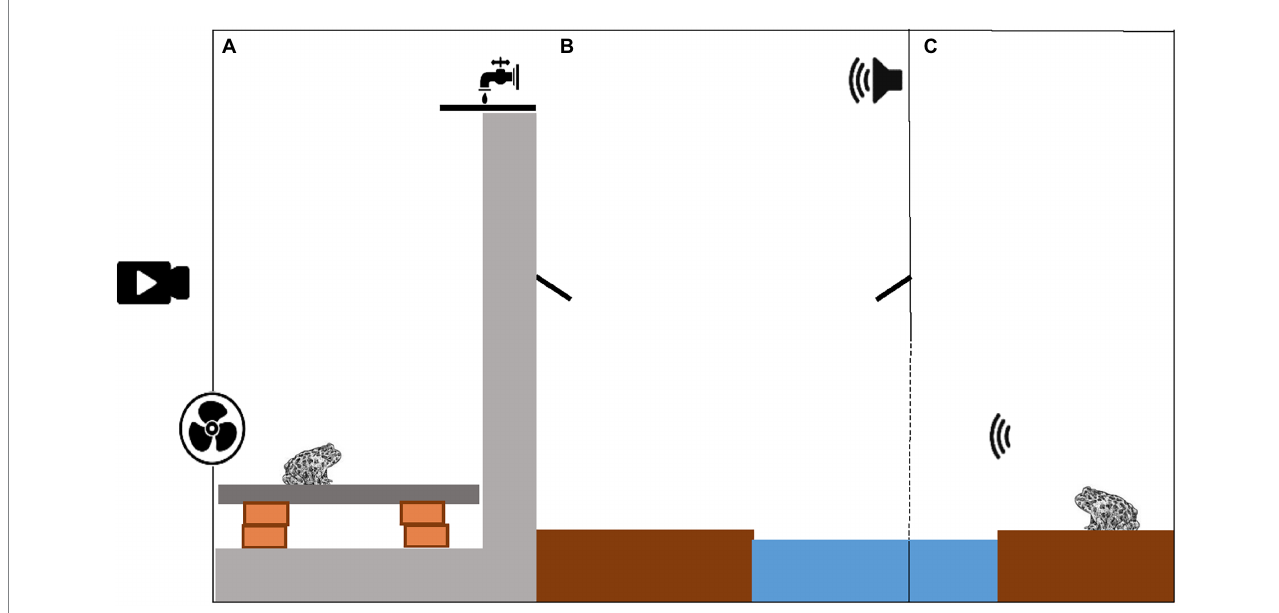
FIGURE 1 Illustration of the experimental arena. The aquatic part is shown in blue, the enriched soil in brown, the fauna fence is shown in grey and the overhangs are represented by solid black lines. The iconography from left to right: camera; ventilation system; species tested; water inlet to wet fence; loudspeaker; singing male. (A) ‘Departure’ compartment (not enriched) with a movable concrete base (shown in dark grey) that allowed modification of test height (see also Figure 3); (B) ‘arrival’ compartment, enriched with sandy soil and moss; (C) compartment with singing males, separated from the ‘arrival’ compartment by a perforated Plexiglass plate (covered with a net), allowing the exchange of visual and olfactory cues in addition to auditory stimulation. Overhangs in the ‘arrival’ compartment were added to prevent individuals that crossed the fence to return to the ‘departure’ compartment.